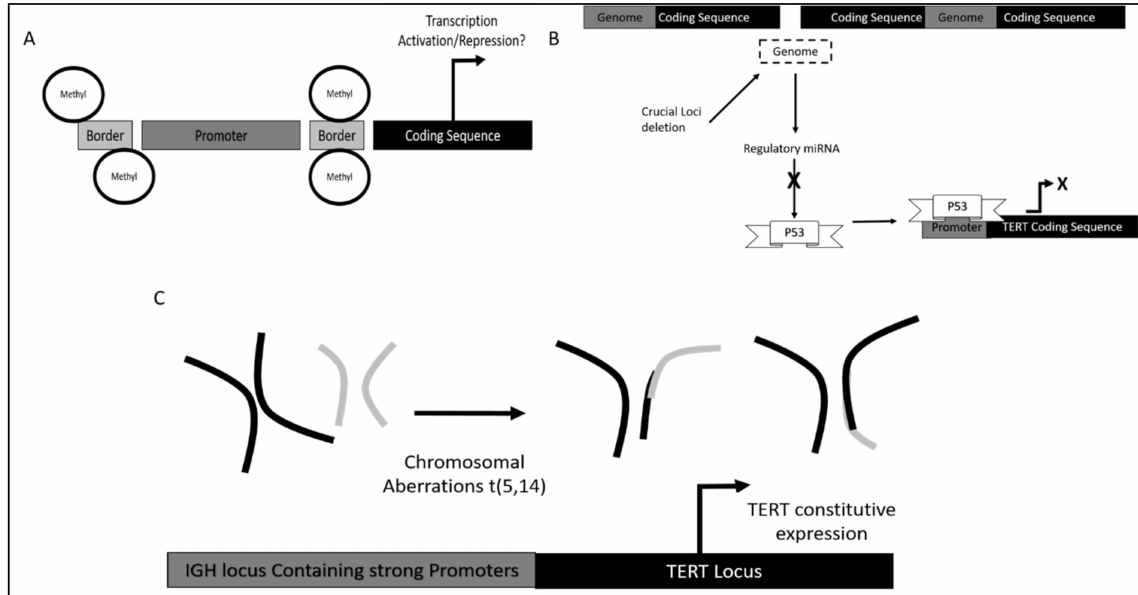
Figure 3. Control of TERT activity and expression occurring in CLL. ( A ) Promoter methylation status; ( B ) chromosomal deletion containing loci encoding for transcription factor suppressors; ( C ) chromosomal aberrations resulting in fusion of critical cis-regulatory elements with TERT coding